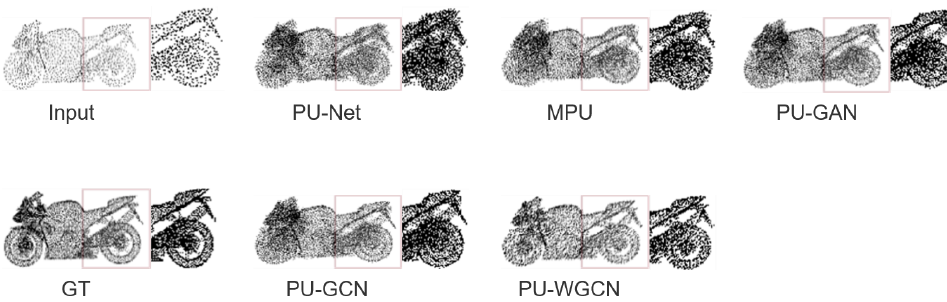
Figure 14. Upsampling visualization results of group d. PU-WGCN retains the motorcycle boundary and hole information well.